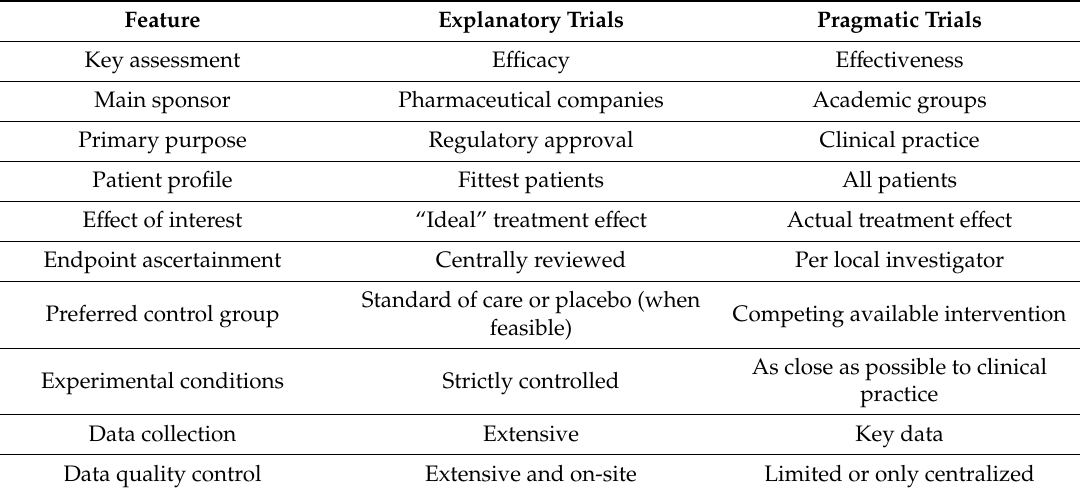
Table 1. Key features of explanatory and pragmatic clinical